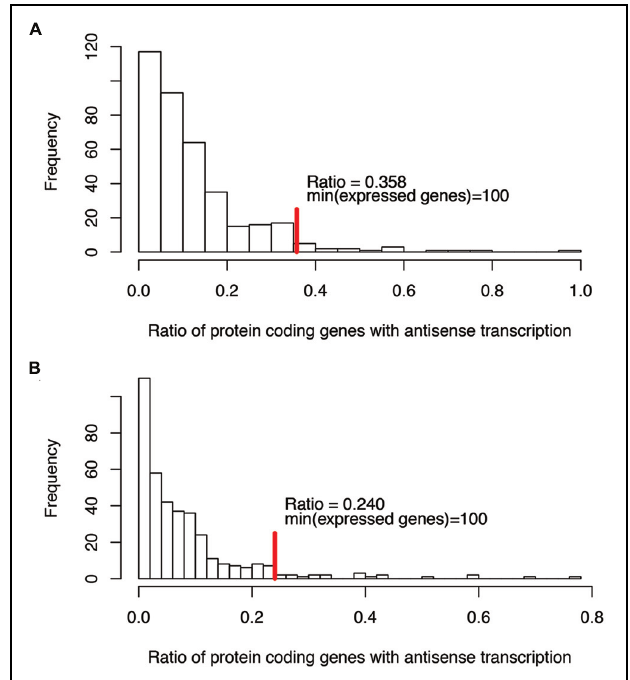
FIGURE 2 | Histograms of the ratios of genes with antisense transcription (over all genes with detectable transcription). Binomial tests were used to determine if a gene has antisense transcription or not, with a success rate of 1% (A) , and 5% (B) , respectively. The red vertical lines indicate the maximum ratios of genes with antisense transcription, for the genomes in which at least 100 genes have detectable transcription (with RNA-seq reads